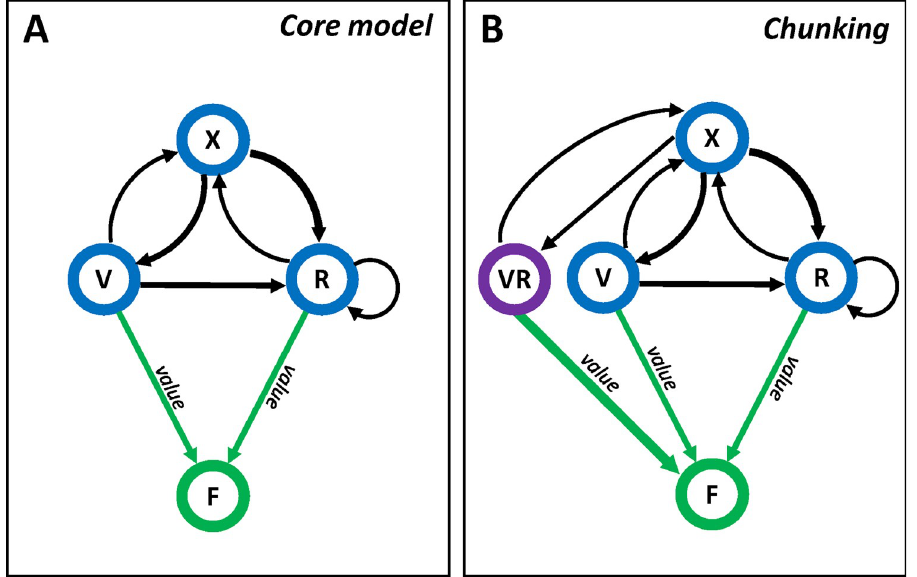
Fig 1. Model design—internal representation. (A) The core model contains a network of 3 elements (blue circles) representing perceived states: V–serving a visitor–client, R–serving a resident–client, X–absence of clients. The value of each node is represented by the weight of its association (width of green arrows) with the reinforcer (food reward; green circle). Edge weights (width of black arrows) represent the strength of the associations between sequential states. This is also the internal representation of the extended credit model. (B) An example of a possible representation in the chunking model: A new element (VR; purple circle) represents the configuration (the chunk) of “V and then R”.